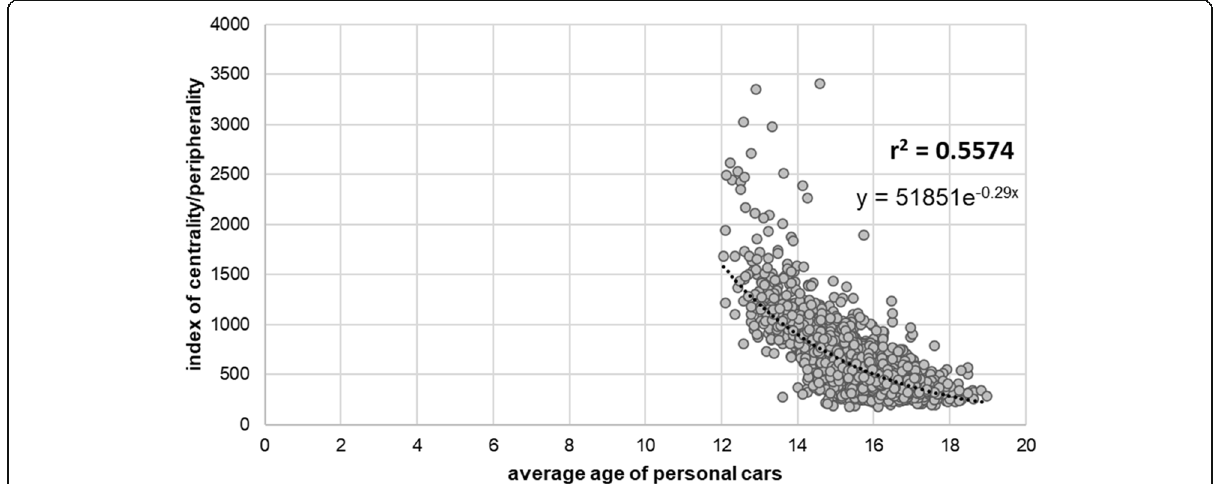
Fig. 8 Relationship between the centrality/peripherality index and the average age of cars. Source: own elaboration based on the Ministry of Finance and Central Vehicle Agency